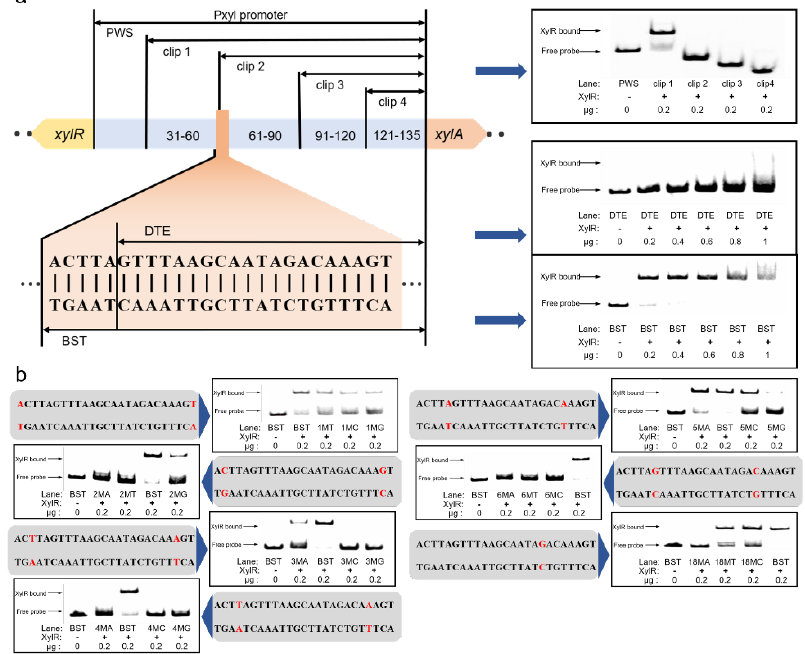
Figure 3. EMSA experiment localizing the XylR binding site in the xylose operon. ( a ) EMSA results of sequence with full and damaged binding sites. Top half shows the XylR protein binding to the truncated promoter confirmed by EMSA; bottom half shows the specific presumed binding site sequence. ( b ) The mutation of seven bases in the binding site affected the XylR protein binding